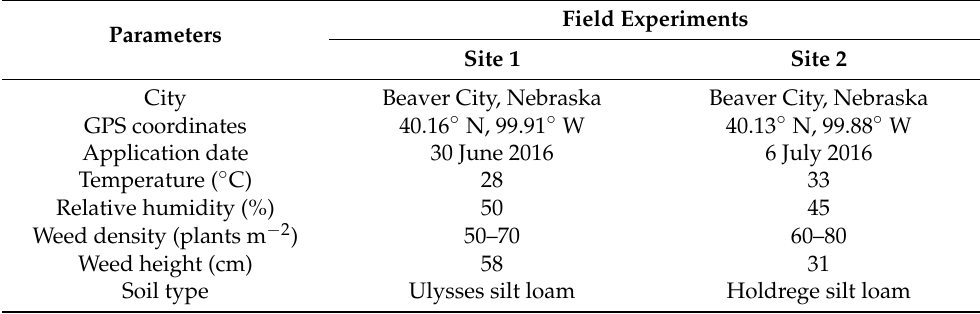
Table 1. Description of the locations used to evaluate the response of Palmer amaranth to glyphosate and PPO-inhibiting herbicides (fomesafen or lactofen) applied alone or in tank-mixtures. Field Parameters